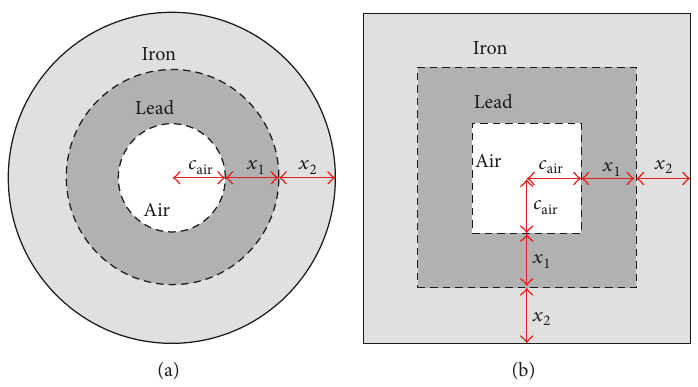
Figure 4: 2 D configuration of container: (a) top view and (b) side view.